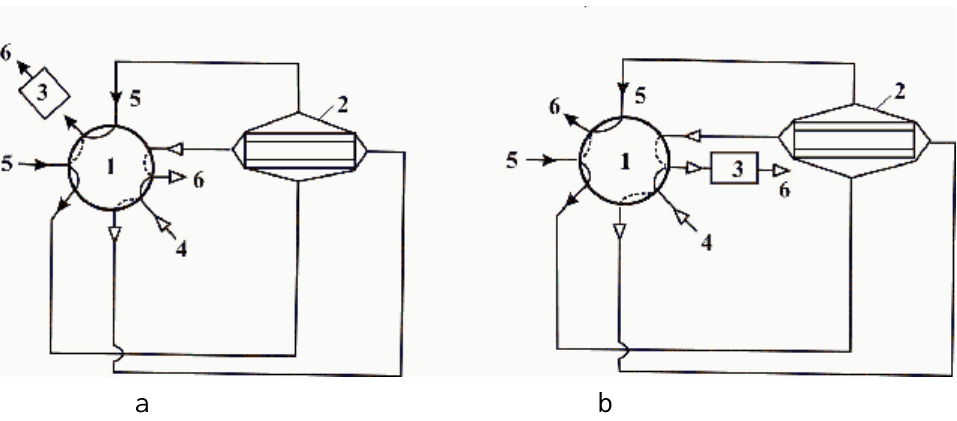
Figure 3. Scheme for chromatomembrane preconcentration from (a) an aqueous and (b) a gaseous phase. 1 valve, 2 CMC, 3 detector, 4 aqueous sample (a) or aqueous absorber solution (b), 5 polar extractant (a) or gas sample (b), 6